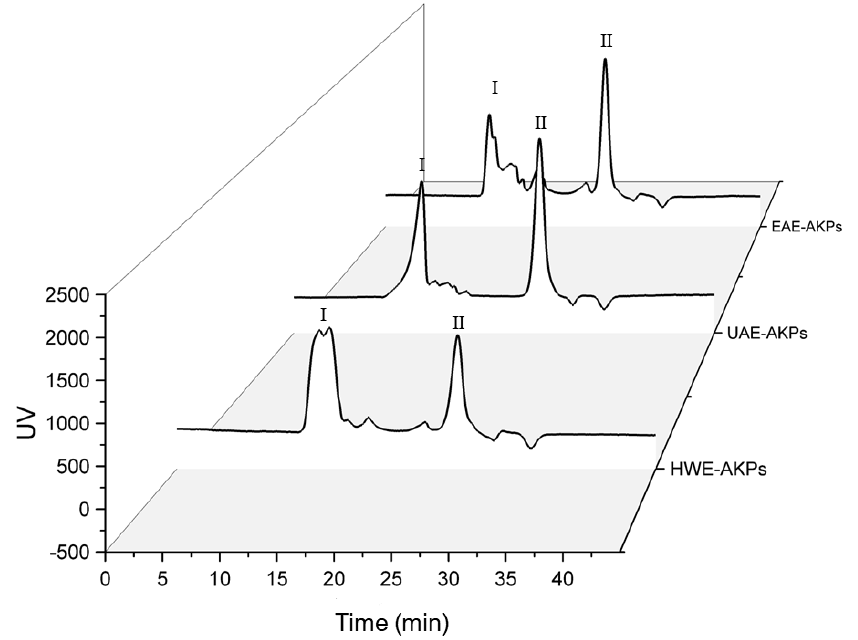
Figure 2. Molecular weight distribution of AKPs extracted by different extraction methods. There are two peaks, characterized as high-Mw parts ( ≥ 3100 kDa, defined as peak I), low-Mw parts (10–4 kDa, defined as peak II).